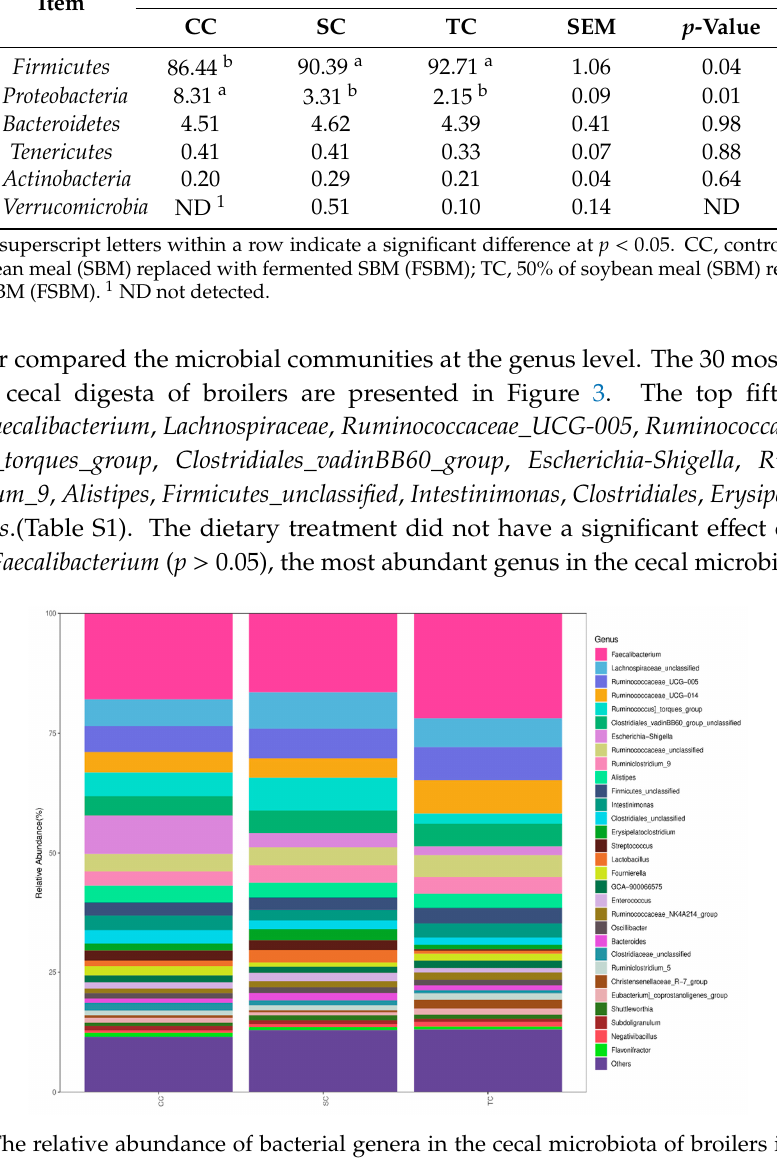
Table 5. Relative abundance of bacterial phyla in the cecal microbiota of broilers in di ff erent groups, %. Relative Abundance, % Item CC SC TC SEM p -Value Firmicutes 86.44 b 90.39 a 92.71 a 1.06 0.04 Proteobacteria 8.31 a